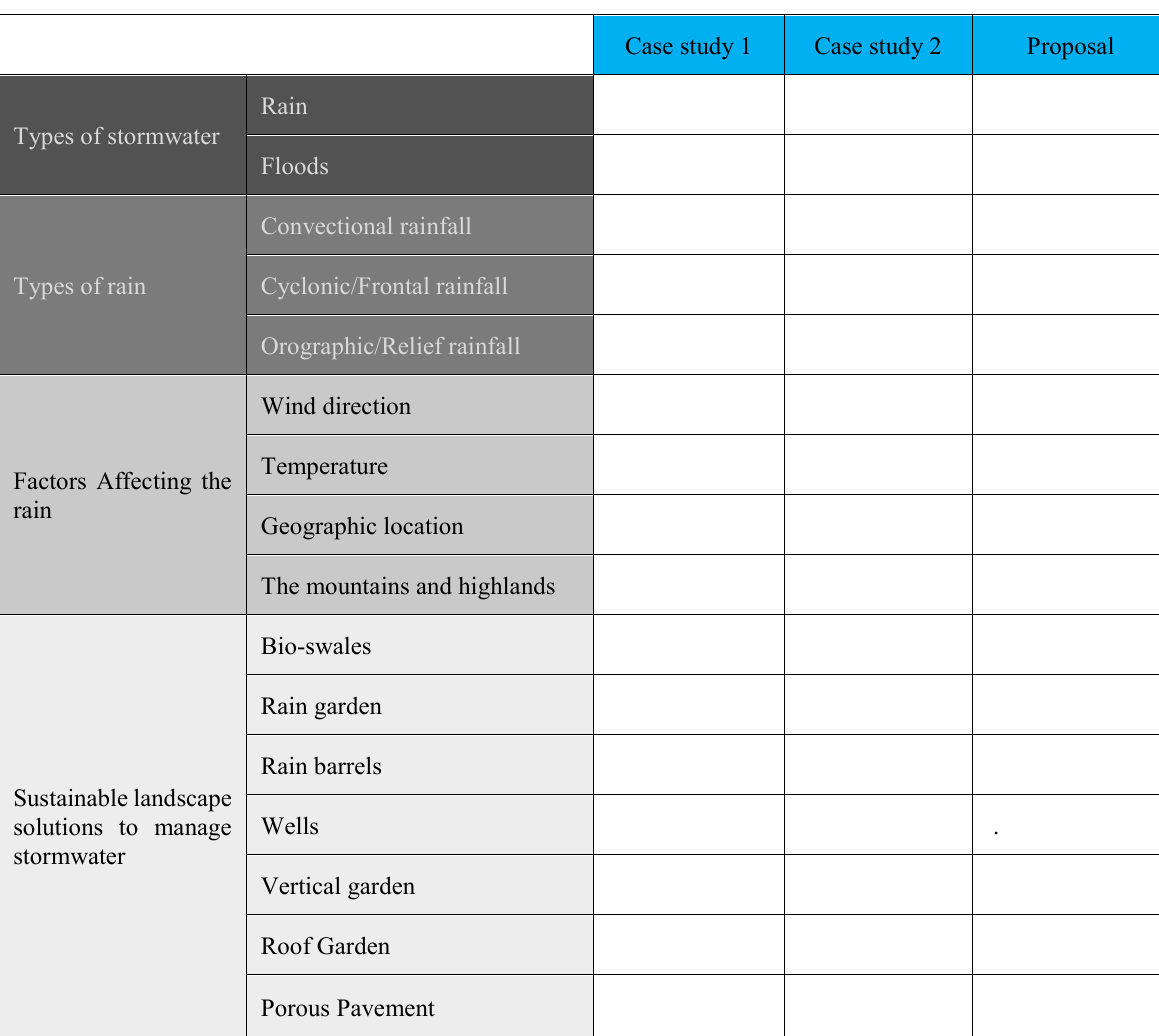
Table 5.Concluded table. (The authors)